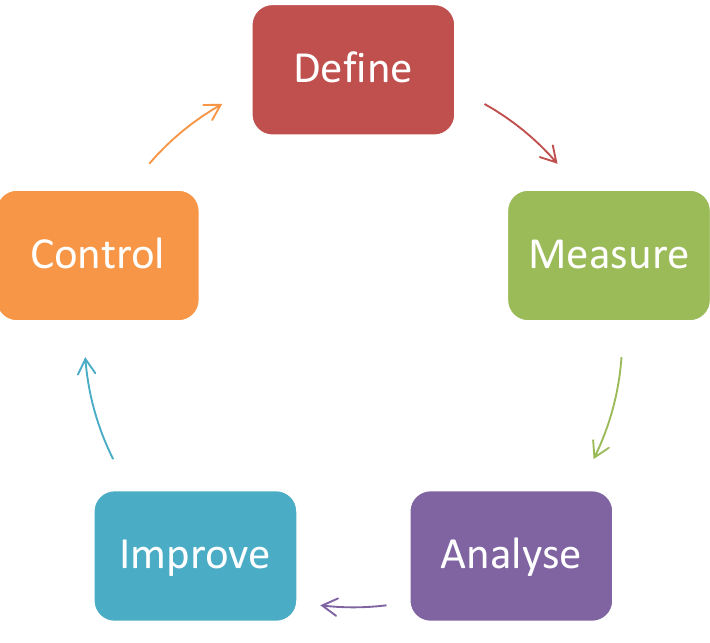
Figure 1. The Six Sigma-DMAIC